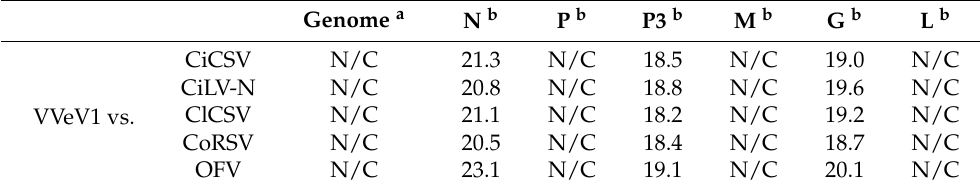
(Figure 1D). A NLS was predicted in every deduced VVe1 protein (Table S3). According to the NLS scores, the N and L proteins should be exclusively localized to the nucleus, whereas the P3 and G proteins are predicted to localize to both the nucleus and the cytoplasm. Leucine-rich NESs were predicted in the N and L protein sequences (Table S3). A transmembrane domain was identified in the C-terminus of the G protein (Table S3). We were not able to identify a consensus gene junction sequence in the genome fragments of VVeV1 (Table 2). Pairwise aa sequence identities between the VVeV1-encoded proteins and those from known dichorhaviruses showed low sequence identities of 20% or less in the P3 and G proteins and 20.5–23.1% in the N protein (Table 6). The phylogenetic analysis based on the N protein aa sequences showed that VVeV1 clusters with the dichorhaviruses but is placed by itself in a sister clade (Figure 2). Table 6. Pairwise identity percentages between VVeV1 and the dichorhaviruses. Genome a N b P b P3 b M b G b L b CiCSV N/C 21.3 VVeV1 vs. OFV N/C 23.1 N/C 19.1 N/C 20.1